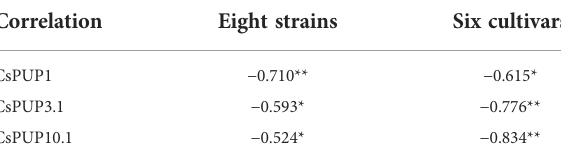
TABLE 2 Correlation analysis of caffeine content and CsPUPs expression.